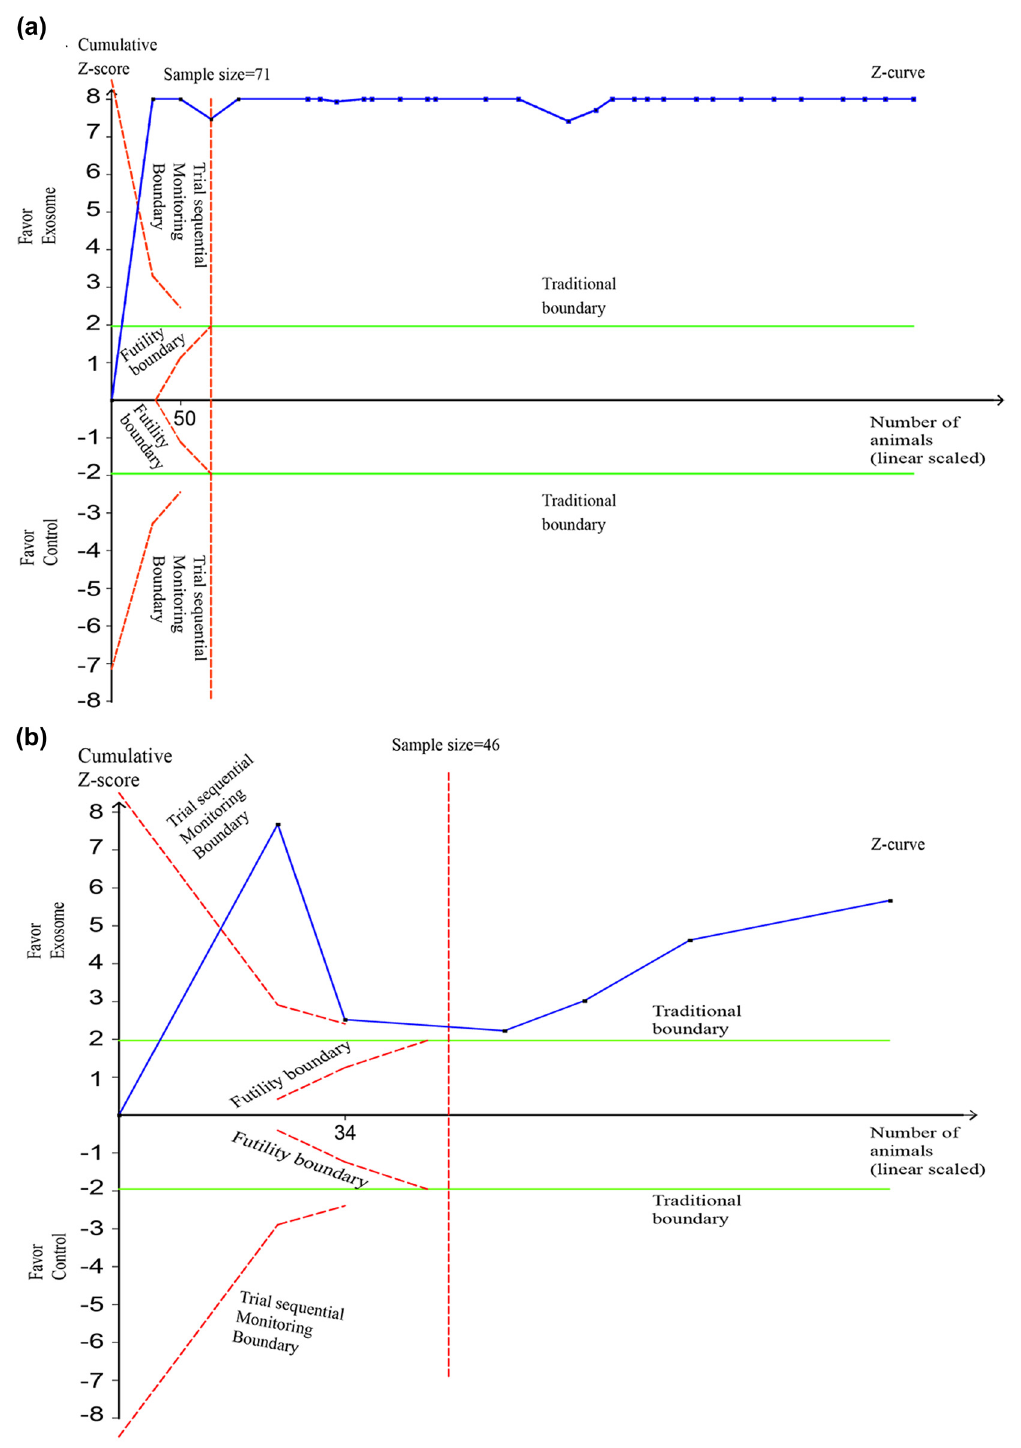
Figure 5: TSAs of the e ff ect of exosomes on locomotor recovery after SCI. ( a ) The adjusted required information size is based on a median value of mean BBB scores of 3.21, an overall signi fi cance level ( α ) of 0.05, a type II risk ( β ) of 0.1 ( power 90% ) , and equals 71 rats ( vertical dotted red line ) . The cumulative Z - curve ( solid blue line ) connected by individual studies ( small squares ) crosses the upper O ’ Brien – Fleming monitoring boundary of bene fi t ( descending dotted red line ) . ( b ) The adjusted required information size is based on a median value of mean BBB scores of 2.46, an overall signi fi cance level ( α ) of 0.05, a type II risk ( β ) of 0.1 ( power 90% ) , and equals 46 rats ( vertical dotted red line ) . The cumulative Z - curve ( solid blue line ) connected by individual studies ( small squares ) crosses the upper O ’ Brien – Fleming monitoring boundary of bene fi t ( descending dotted red line )